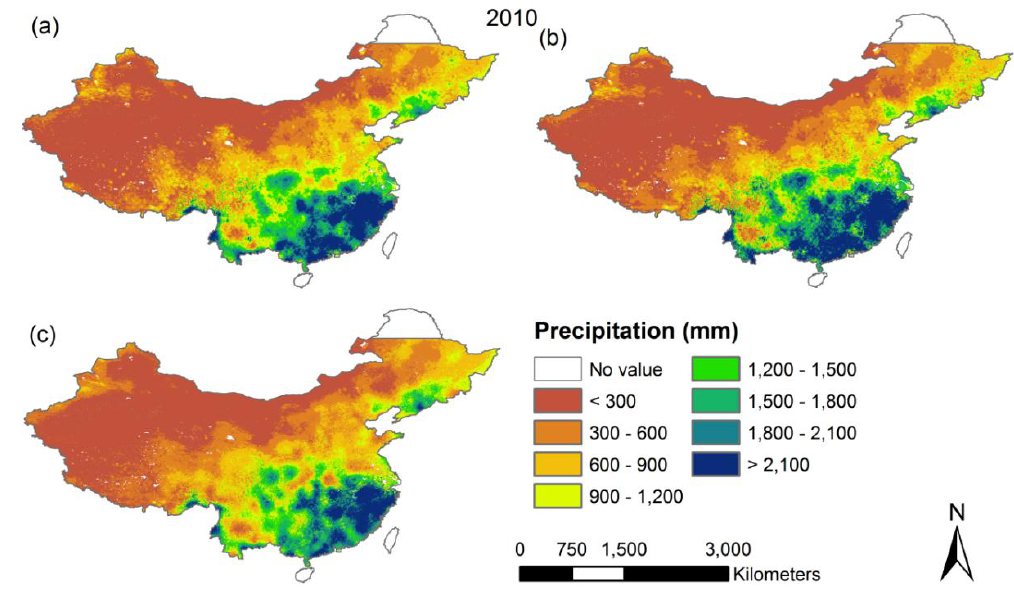
Figure 4. The final predicted annual precipitation of Mainland China at a 1 km resolution for the years of 2001 and 2010, using ( a ) the multiple linear; ( b ) exponential; ( c ) Random Forest and regression model,